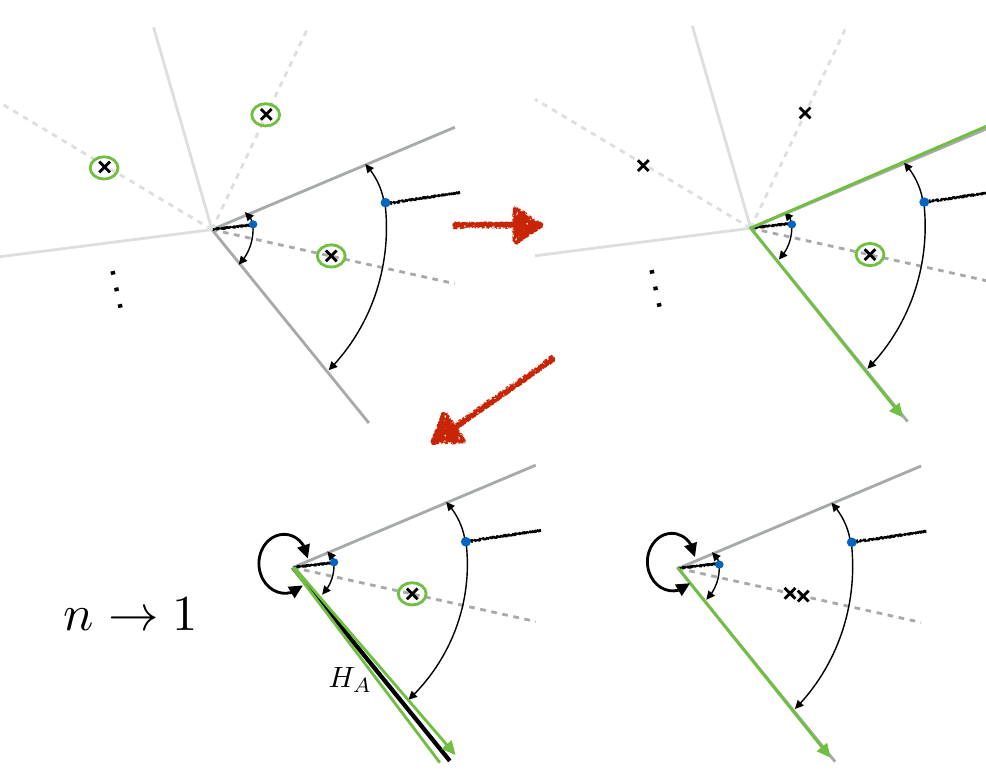
Figure 4 . An illustration of the procedure to analytically continue the two point function in n and extract the limit as n 1. We schematically plot the (cid:21) plane with the slices of the pie representing ! di(cid:11)erent replicas and with the dashed lines lying along the positive real (cid:21) axis on each replica. We integrate (cid:21) over the green curves and the fuzzy black lines represent branch cuts coming from lightcone singularities. The cross represents a simple pole and the double cross is a double pole. The two top (cid:12)gures are at (cid:12)xed integer n . The continuation proceeds from the second top picture and the leading correction as n 1 comes from pulling down a factor of the modular Hamiltonian ! which is wedged between the straight line integration contour. This results in a commutator which gives rise to the double pole shown on the bottom right (cid:12)gure. The (cid:12)rst term in (3.20) comes from the integral around the simple pole in the bottom left